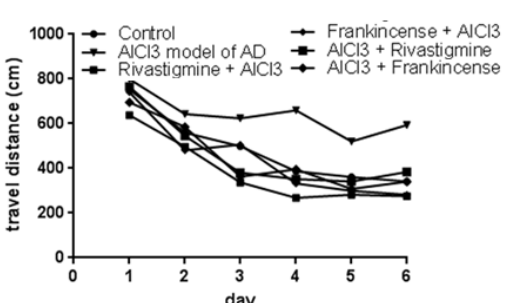
Fig. 2. Travel distance parameter: The graph represents a clear difference in the recorded scores of AD model rats and the other groups. The results reported as means ± SD.